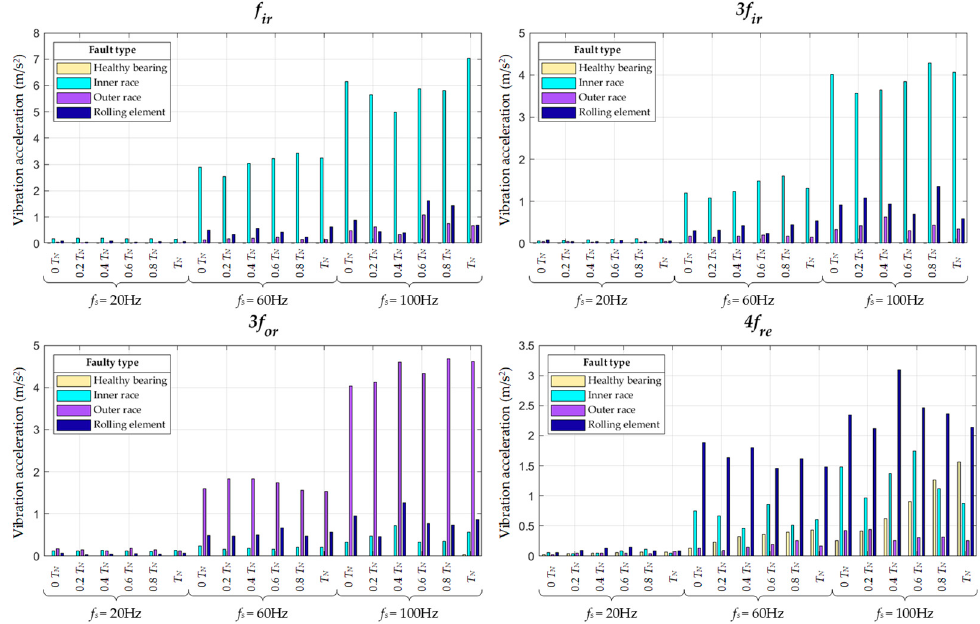
Figure 7. Examples of harmonic amplitudes with characteristic frequencies obtained using envelope (ENV) for vibration acceleration signal; different load torques and supplying frequencies of PMSM drive.